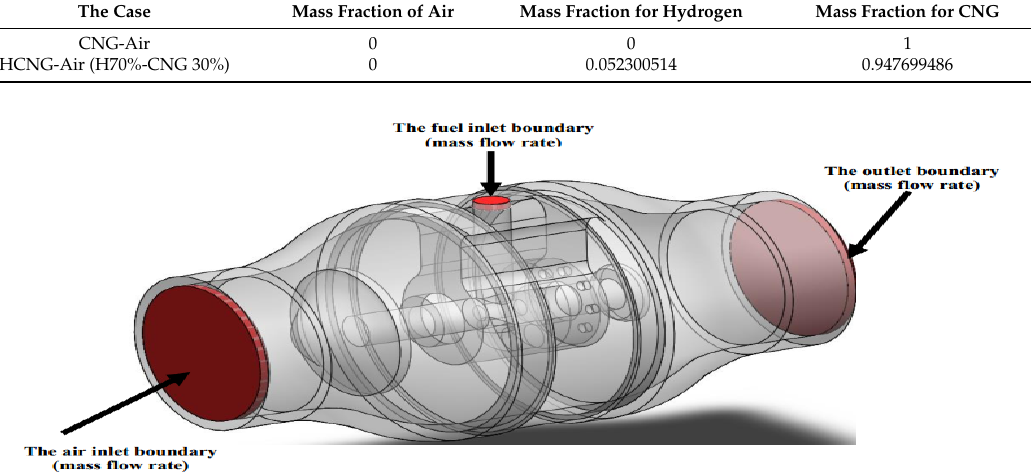
Table 4. Diesel and Gaseous fuel properties [44,47].